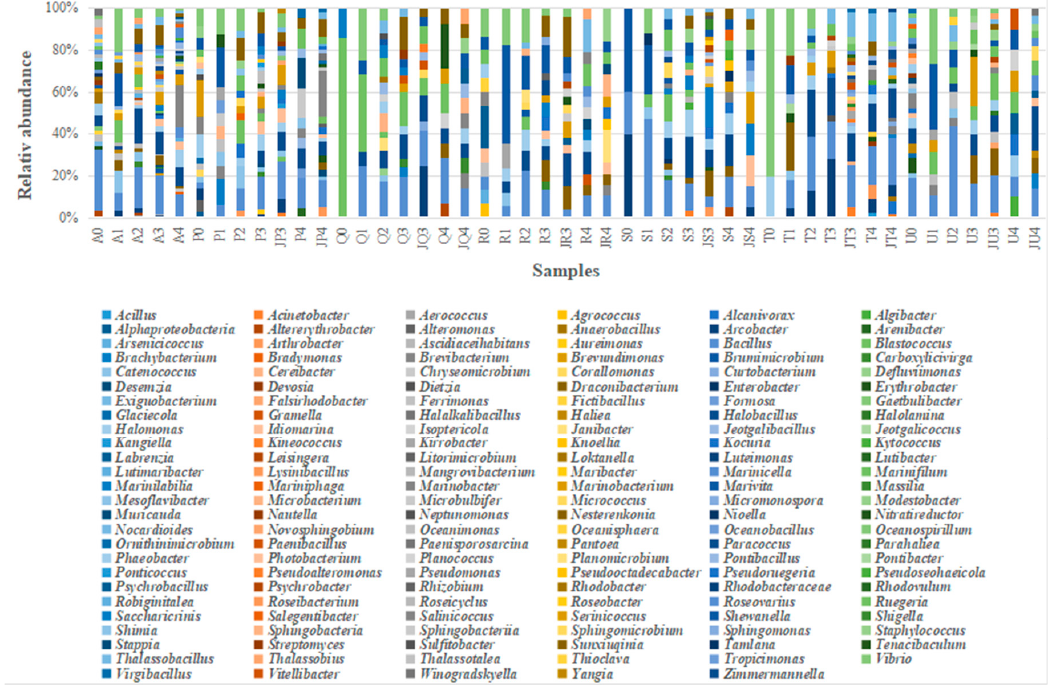
Figure 3. Culturable bacterial community compositions of all the samples at genus